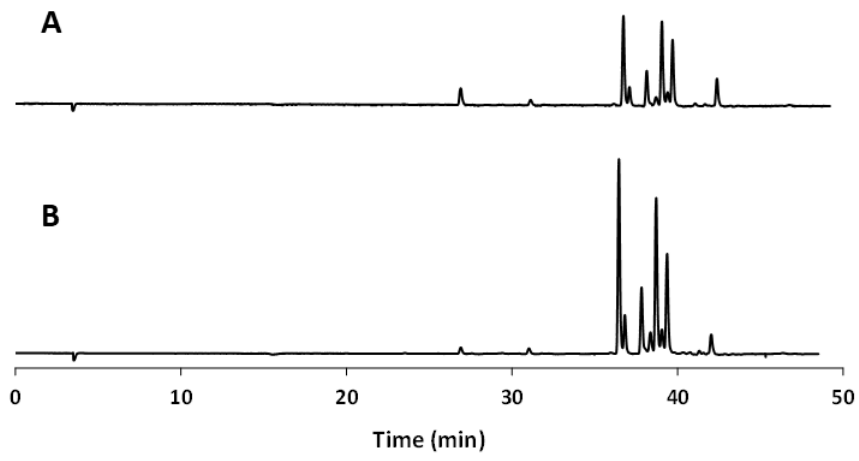
Figure 2. HPLC-UV chromatographic profile of the best performing AP samples: OD with PS 250 – 400 μm ( A ); HFD with PS > 400 μm ( B ).